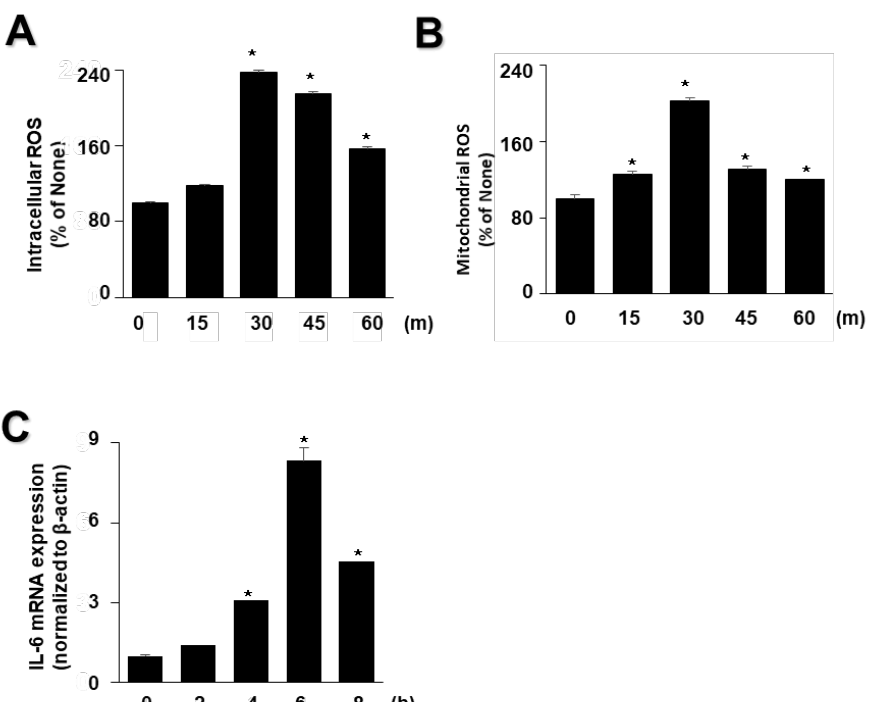
Figure 2. Effect of ethanol (EtOH)/lipopolysaccharides (LPS) on the levels of reactive oxygen species (ROS) and IL-6 mRNA in AR42J cells. Cells (2 × 10 5 /2 mL/well) were stimulated with EtOH (at a final concentration of 250 mM)/LPS (10 μg/mL) for the indicated periods. ( A ) Intracellular ROS levels were determined by dichlorofluorescein (DCF) fluorescence. ( B ) Mitochondrial ROS levels were measured by determining the level of fluorescent MitoSOX. The value for ROS levels at the start of the experiment (at 0 min) was set at 100%. ( C ) mRNA expression of IL-6 was determined by real-time polymerase chain reaction and normalized to that of β -actin. The IL-6 mRNA level at the start of the experiment (at 0 h) was set as 1. Data are expressed as the mean ± SE ( n = 12 in each group). * p < 0.05 vs. the cells at the start of the experiment (at 0 min or 0 h).